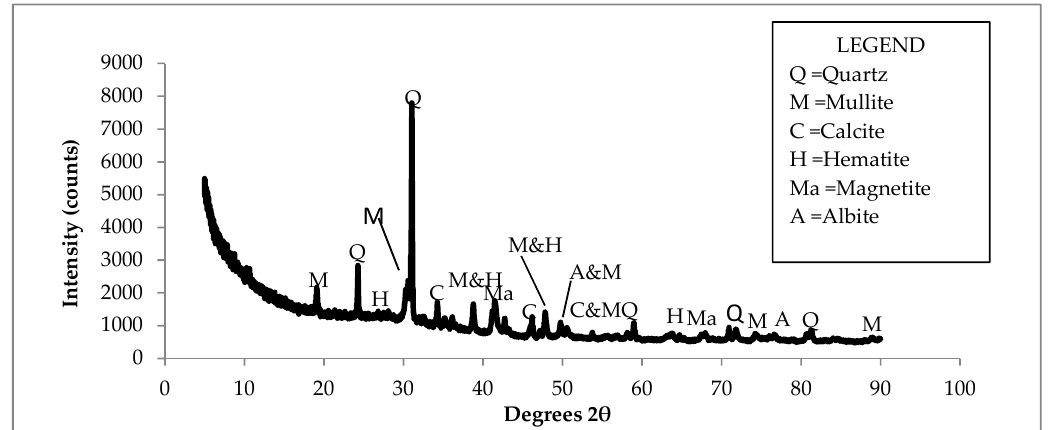
Figure 3. X-ray diffraction (XRD) spectrum of the CFA.